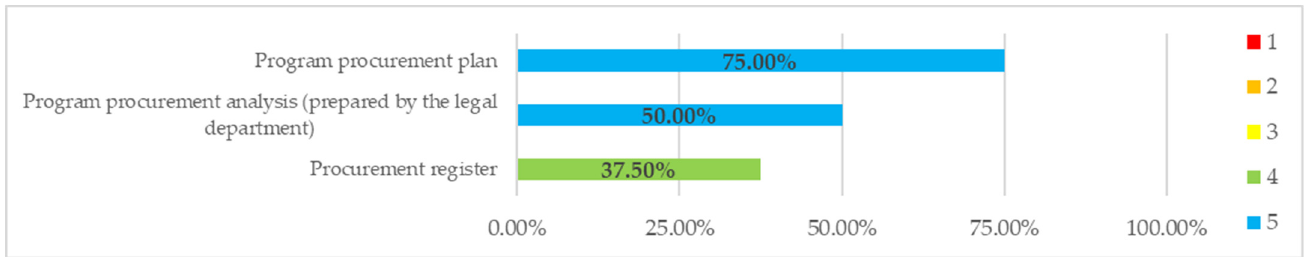
Figure 9. Evaluation of the effectiveness of the methods, techniques and tools used for the procurement control process. Source: own elab.